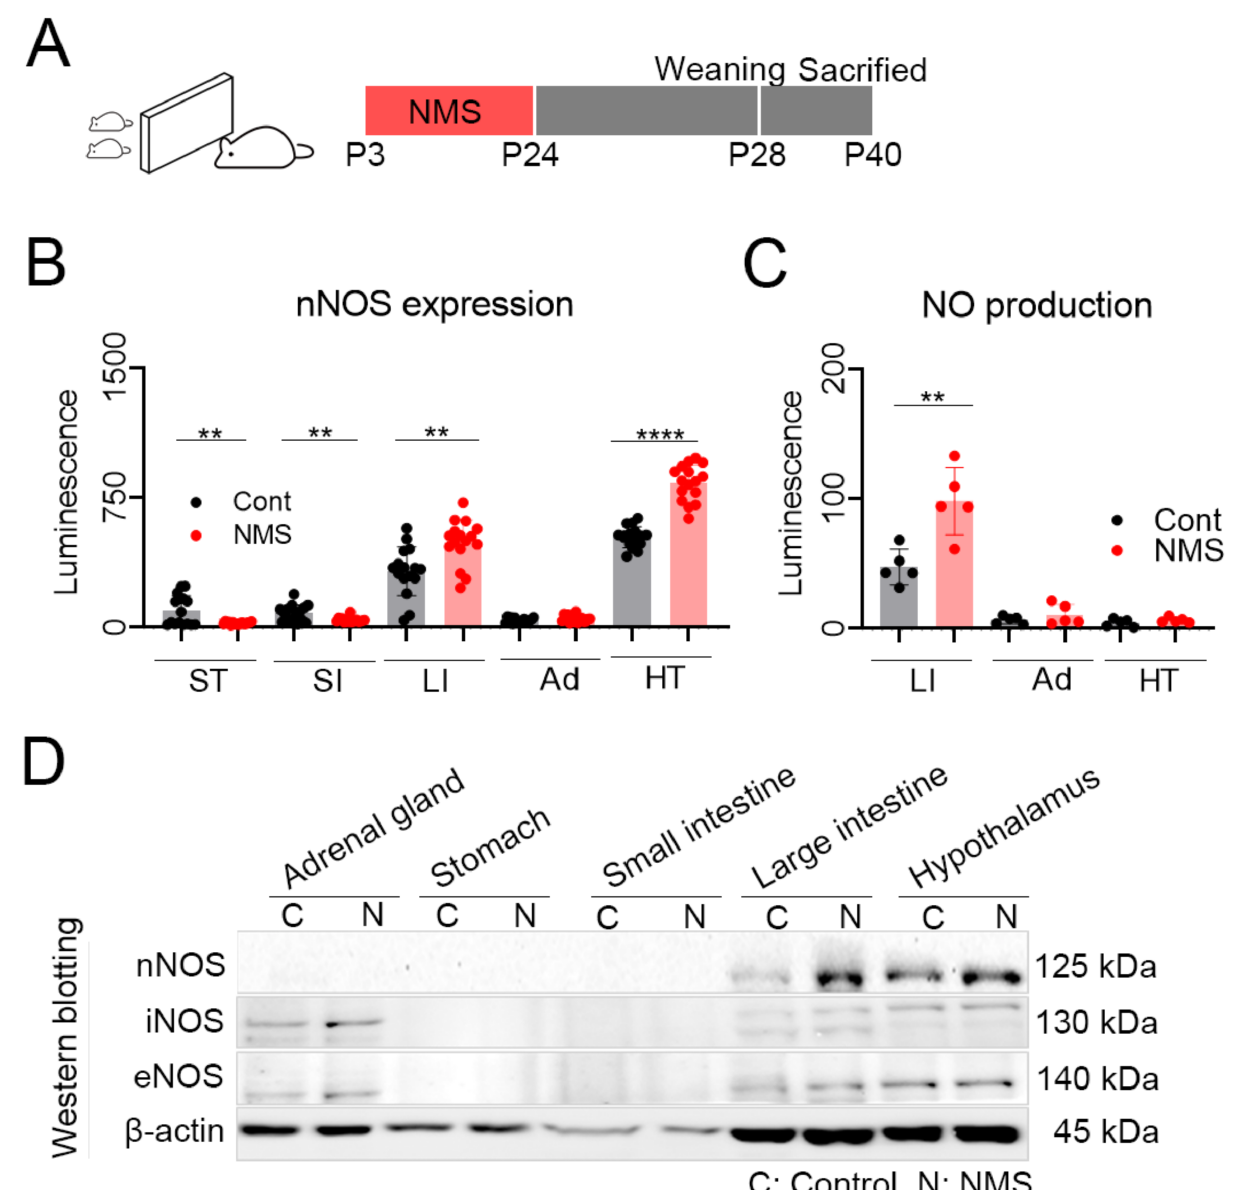
Figure 2. NMS-mediated IBS mouse model and analysis nitric oxide concentration. ( A ) Schematic for inducing NMS- mediated IBS mouse model. Briefly, NMS was conducted for 3 h per day for 21 consecutive days (3–24 days old). Mice were weaned at 28 days old, and sacrificed and sampled at 40 days old. ( B ) nNOS-HiBiT expression was analyzed by HiBiT lytic analysis, and each dot indicates data from the individual animals (control, n = 16, NMS, n = 16). nNOS-HiBiT expression was displayed as a luminescence intensity and represented as a mean ± SEM. ( C ) Nitric oxide (NO) concentration was analyzed with the large intestine, adrenal, and hypothalamus tissues (control: n = 5, NMS: n = 5). Statistical analysis was performed using Student’s t -test. **: p < 0.01 and ****: p < 0.0001. ST: Stomach, SI: Small intestine, LI: Large intestine, Ad: Adrenal gland, HT: Hypothalamus. ( D ) NMS was conducted using wild-type mouse, and mice from each group were sacrificed and sampled at 40 days old. Tissue sample proteins from 5 mice with the same group (control vs. NMS) were quantified and merged, and subjected to western blotting to detect iNOS, eNOS, and nNOS. iNOS: inducible NOS, eNOS: endothelial